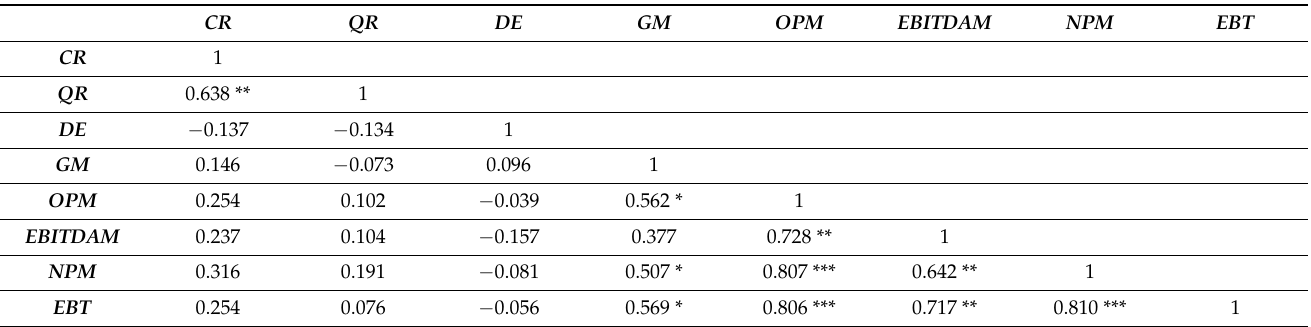
Table 2. Correlation